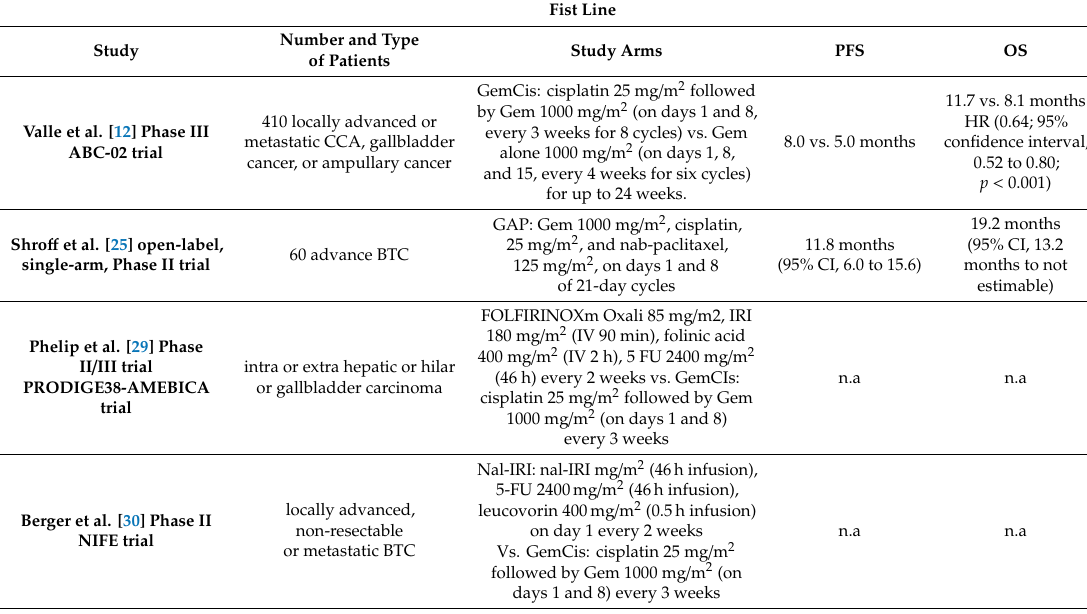
Table 2. Summary of first-line treatments in advanced